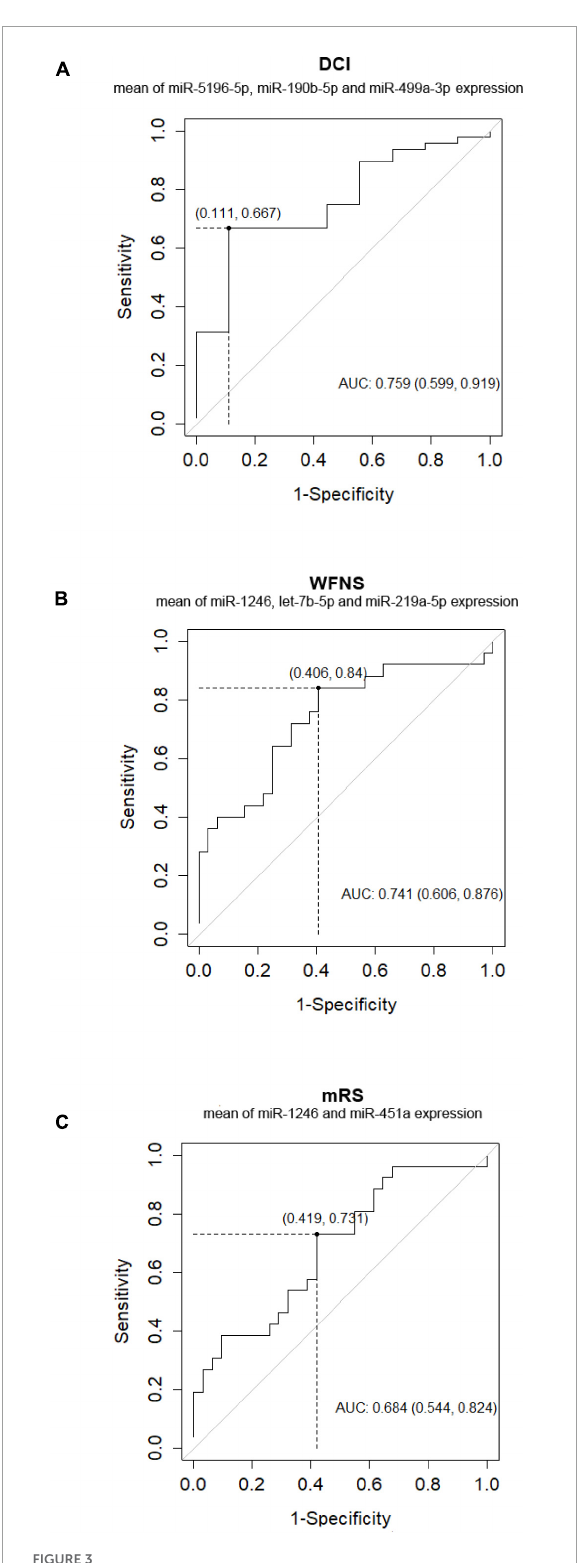
FIGURE3 Receiver operating characteristic (ROC) analysis curve for DCI (A) , WFNS (B) , and outcome at 3 months (C) prediction scoring system by mean of few